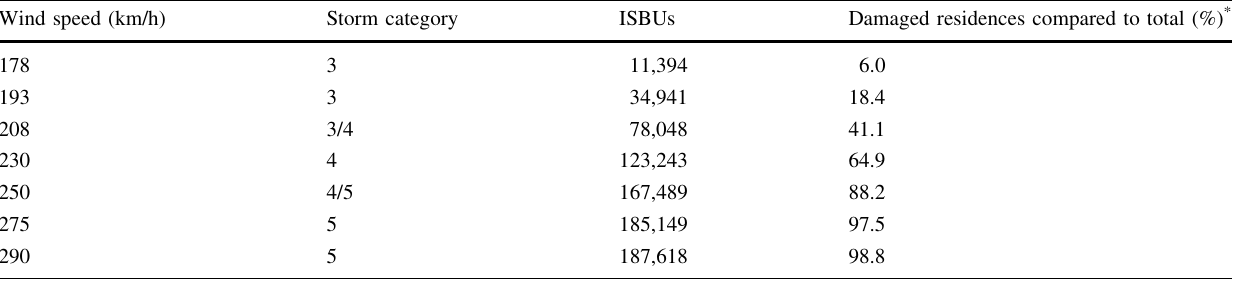
Table 2 Number of temporary intermodal steel building units needed in New Orleans following hurricane hazards of a given intensity Wind speed